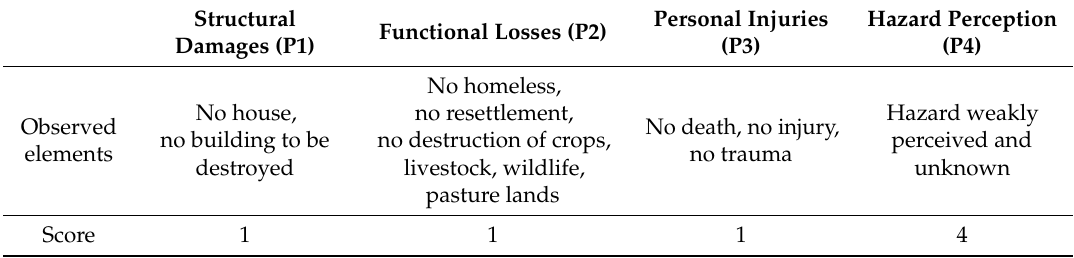
Table 9. Severity assessment of the lake Nyos flood hazard after jet grouting implementation.